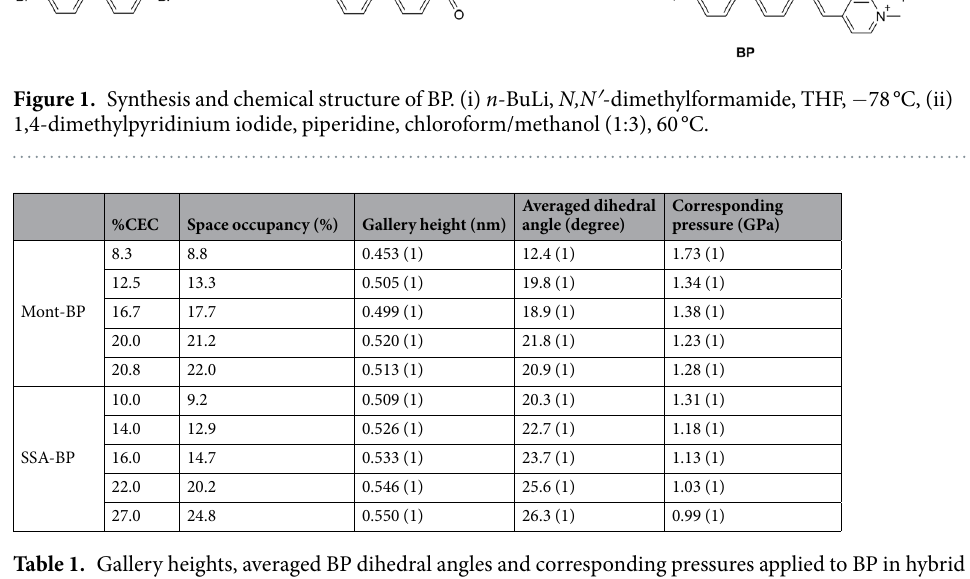
Table 1. Gallery heights, averaged BP dihedral angles and corresponding pressures applied to BP in hybrid films fabricated at various space